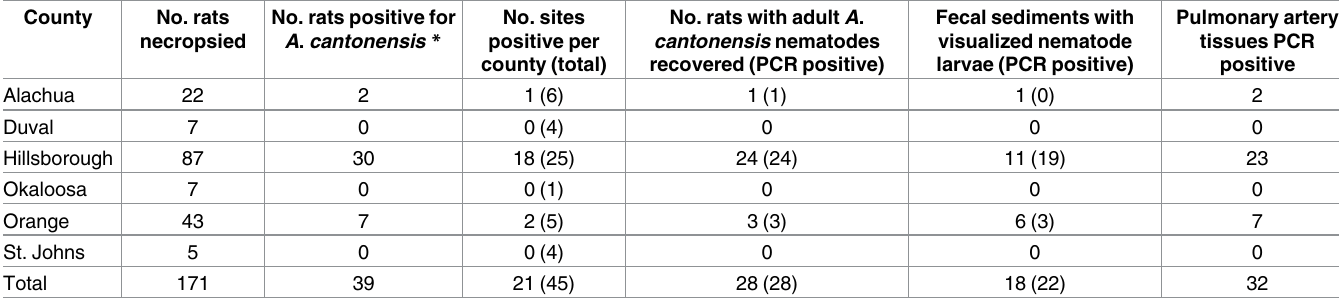
Table 1. Rats ( Rattus rattus ) collected and necropsied from multiple sites in 6 counties in Florida. County No. rats No. rats positive for necropsied A . cantonensis *